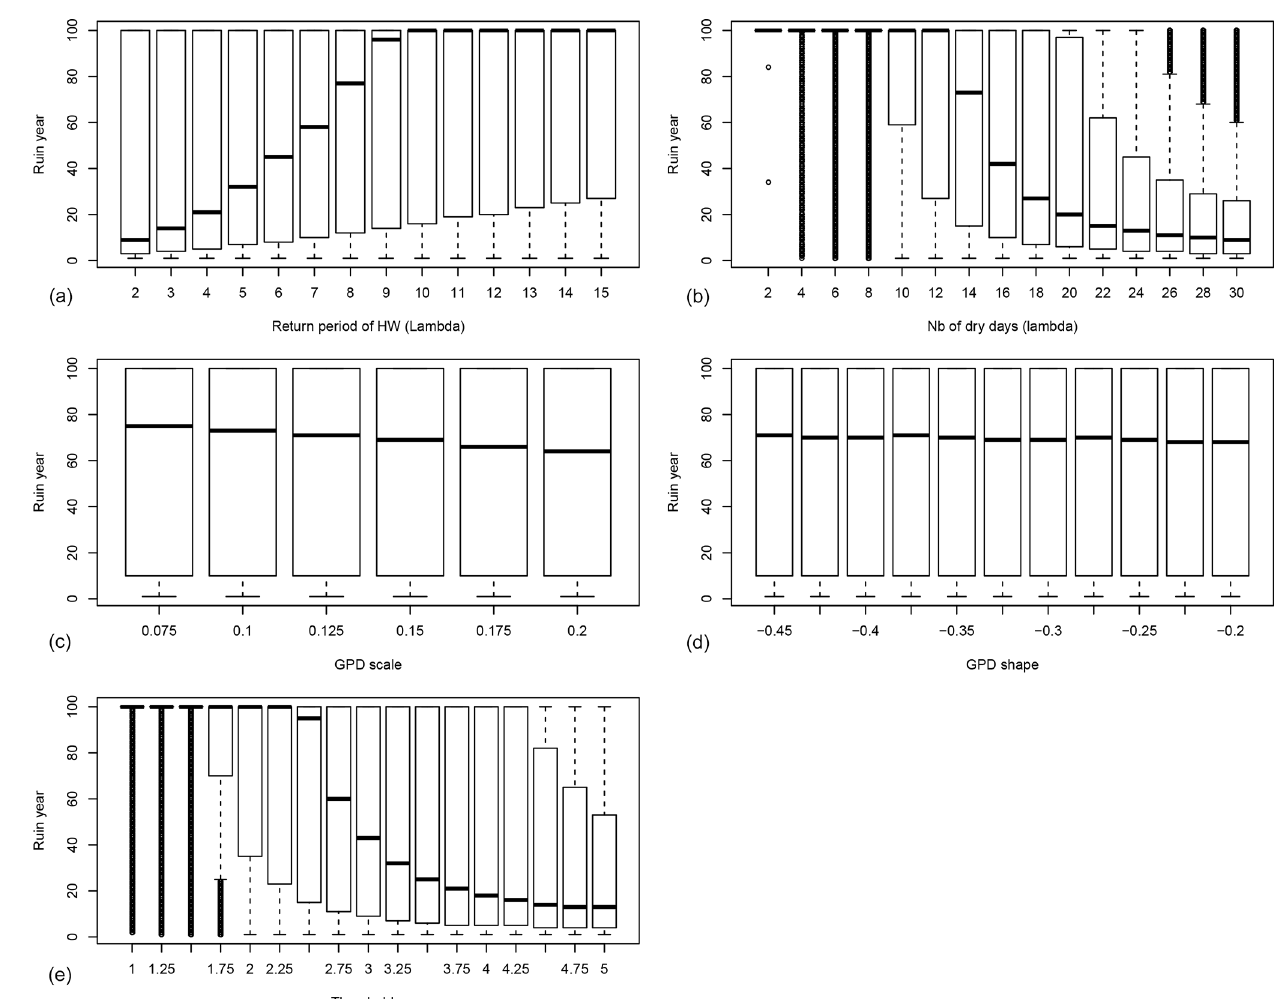
Figure 2. The probability distribution of the ruin year τ as functions of the drought–heatwave (HW) return period (cid:51) (a) , the number of days when I YV exceeds the threshold u during summer λ (b) , GPD scale σ (c) , GPD shape ξ (d) and the threshold u above which damage S ( t ) is triggered (e) . B = 0 in all experiments. For each value of the control variable, a boxplot is given. The thick horizontal bar in each box represents the median ( q 50) of the distribution. The boundaries of each box represent the 25th quantile ( q 25) and the 75th quantile ( q 75). Each upper whisker represents min [ max( τ ) , 1 . 5 × ( q 75 − q 25) + q 50 ] . The lower whiskers are min [ max( τ ) ,q 50 − 1 . 5 × ( q 75 − q 25) ] . The small circles represent data that are above or below the whiskers; note that the circles below the lower whiskers tend to be close to each other and therefore appear like thick vertical